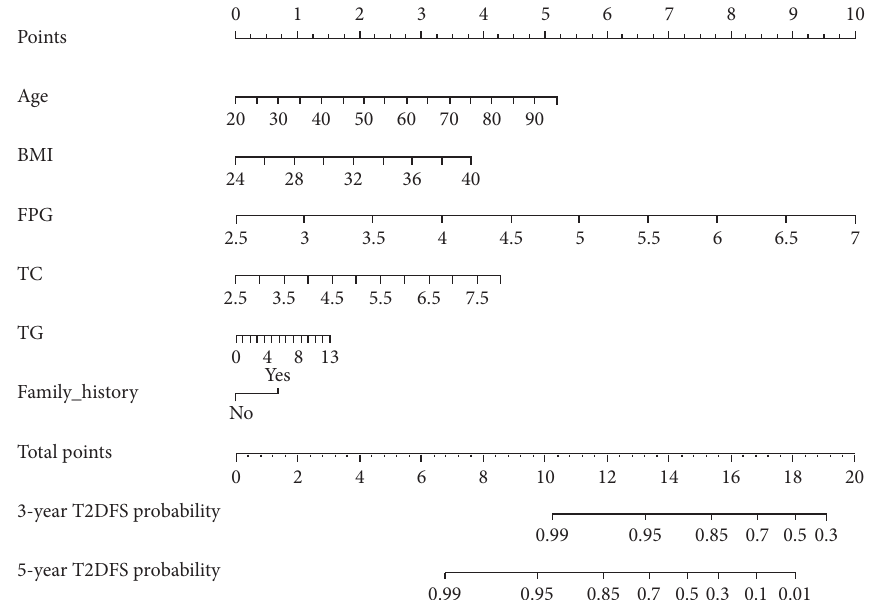
Figure 2: Nomogram to predict 3- and 5-year T2DFS probability for overweight/obese population. T2DFS, type2 diabetes-free survival; BMI, body mass index; FPG, fasting plasma glucose; TC, total cholesterol; TG, triglycerides.